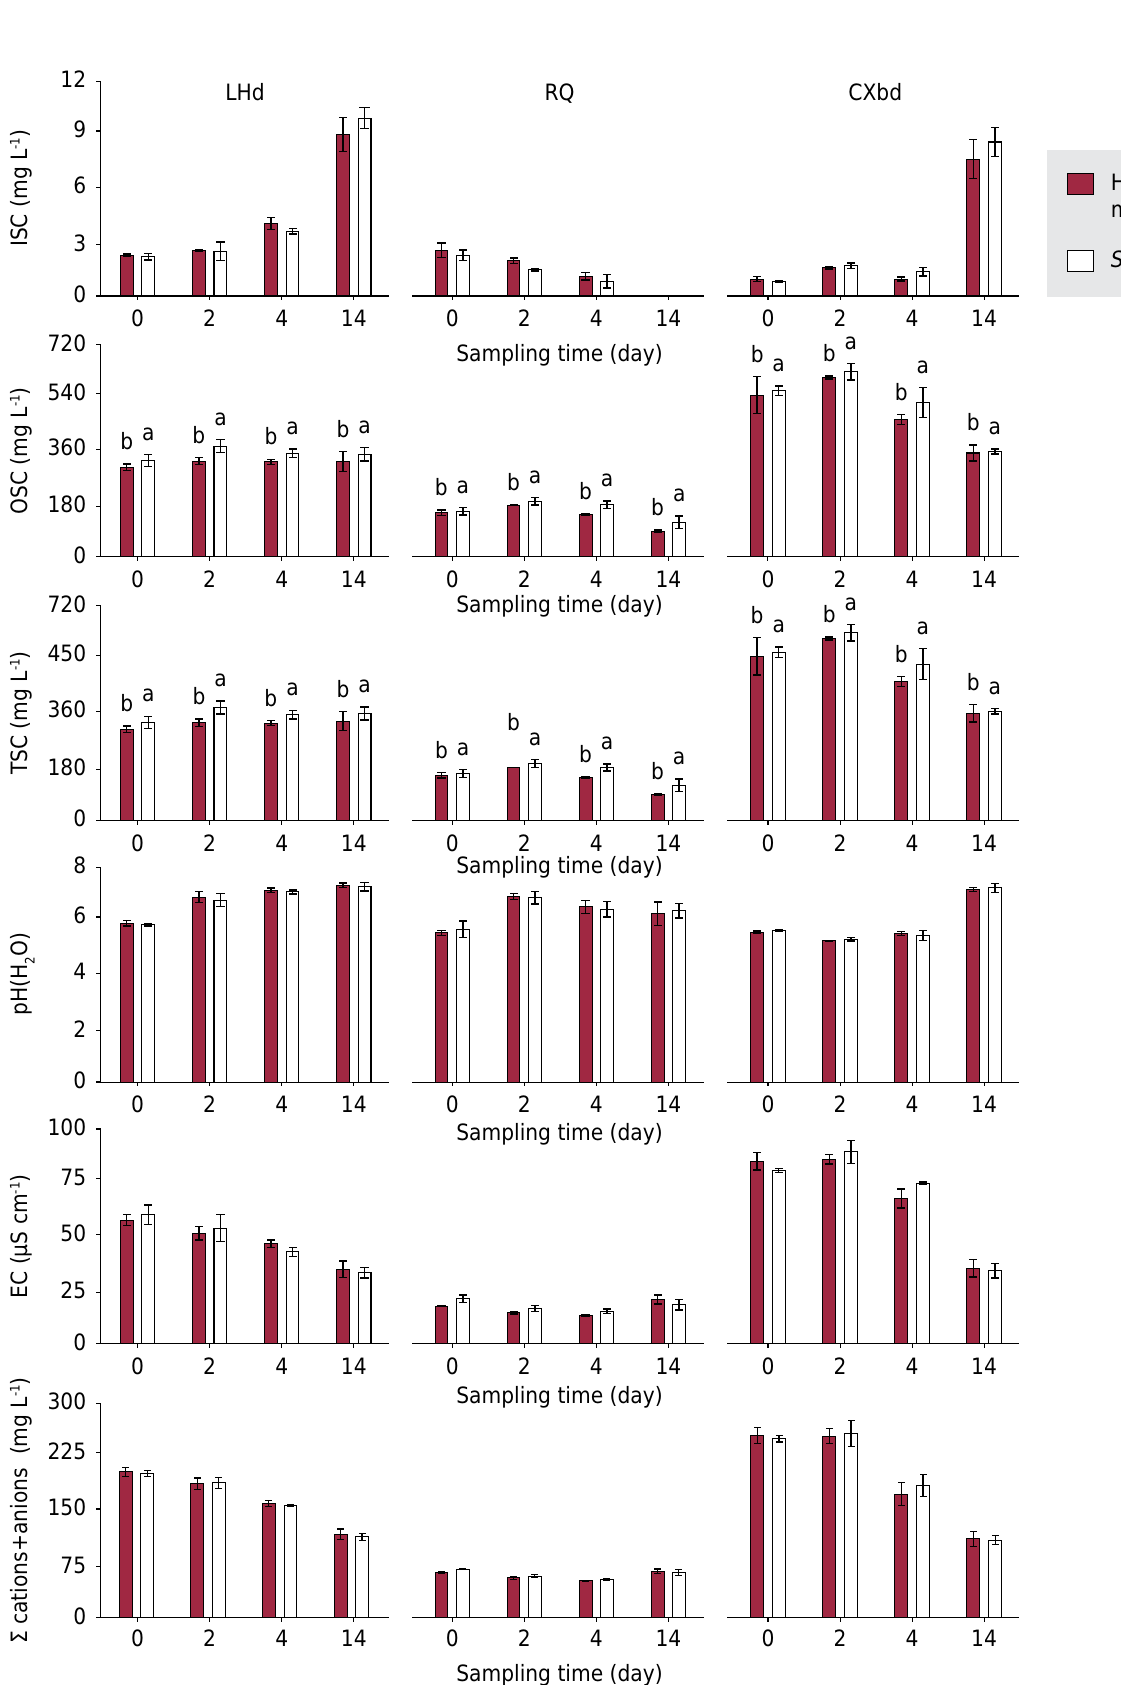
Figure 4. Soluble inorganic C (SIC), soluble organic C (SOC), and total soluble C (TSC) concentrations, pH values, and electrical conductivity (EC) of solutions of the studied soils. Variables were measured in solutions extracted in four sampling times by the Suolo Acqua and hydrophilic membrane (HM) samplers. LHd - Latossolo Húmico Distrófico, RQ - Neossolo Quartzarênico and CXbd - Cambissolo Háplico Tb Distrófico. Mean values followed by the same letter in each sampling time and soil investigated did not differ statistically by the F test